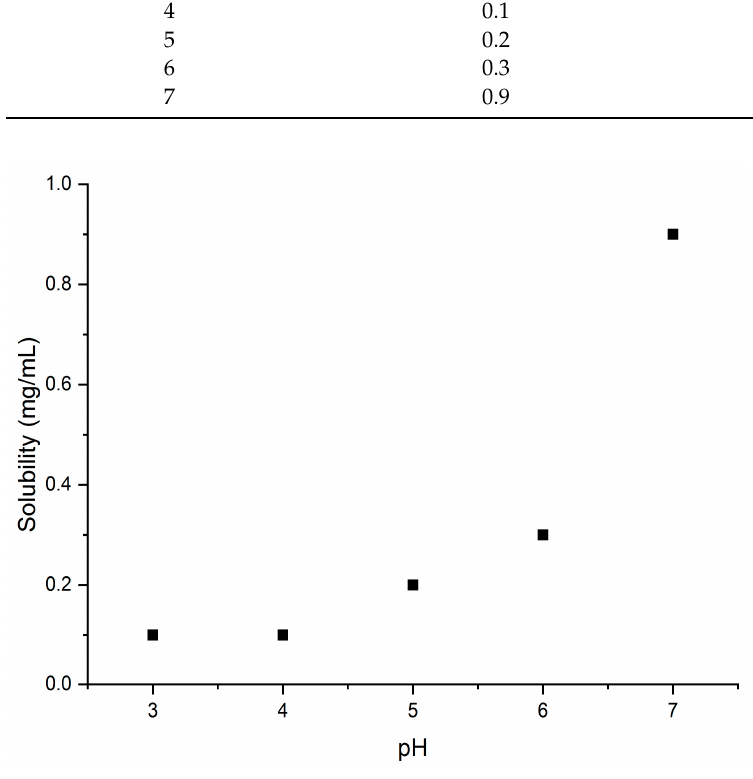
Figure 9. Dependance of warfarin sodium solubility on the pH value.